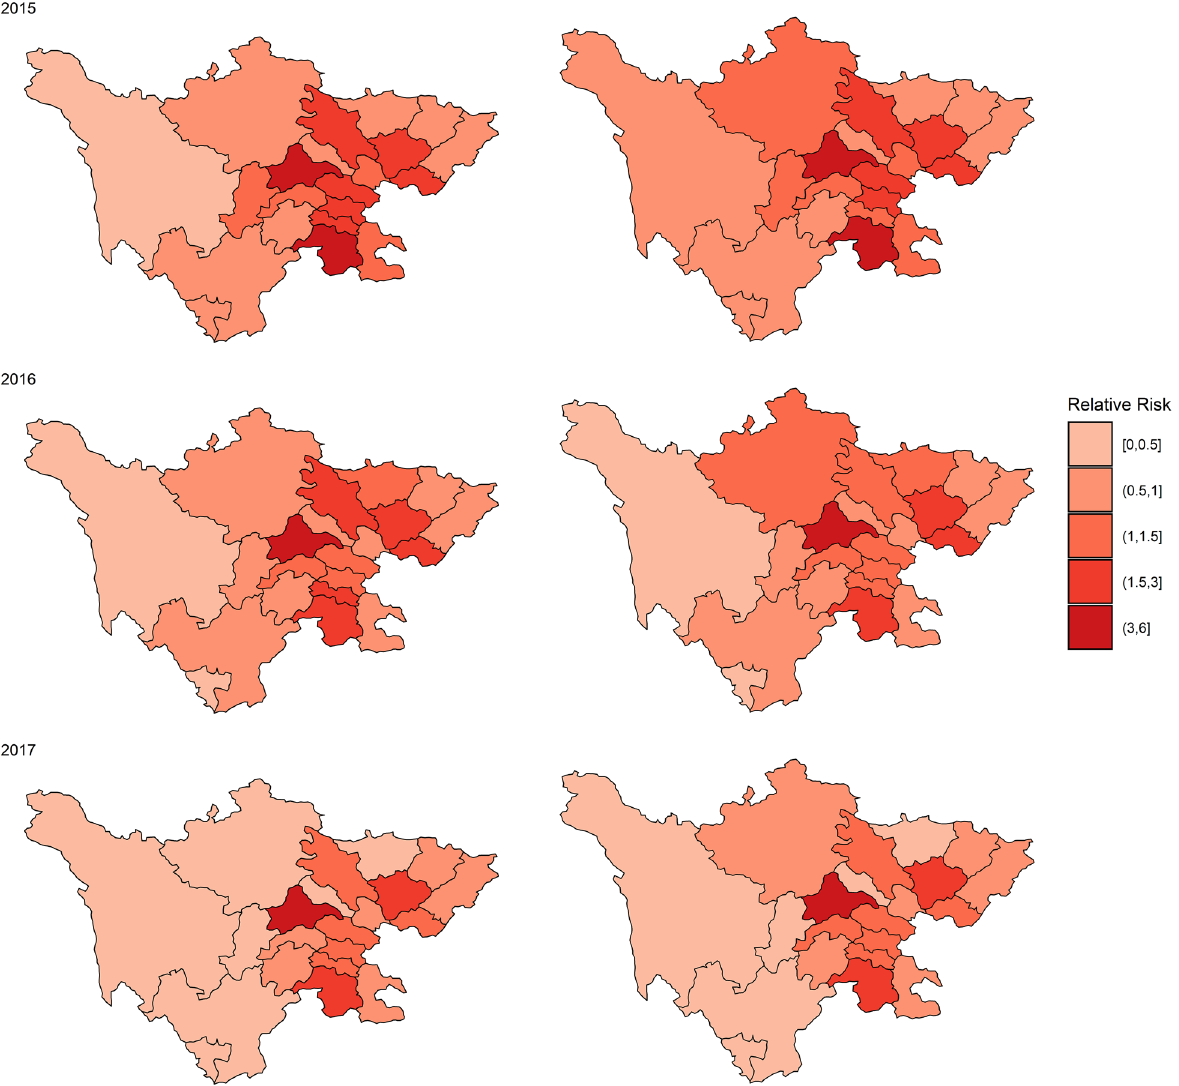
Figure 2. Annual RRs of HFMD in 21 cities in Sichuan from 2015 to 2017 by the model without covariables (left) and the model with air pollutants